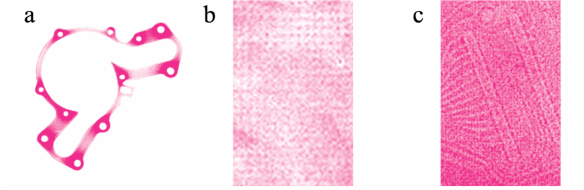
Fig.2. Examples of Pressurex film